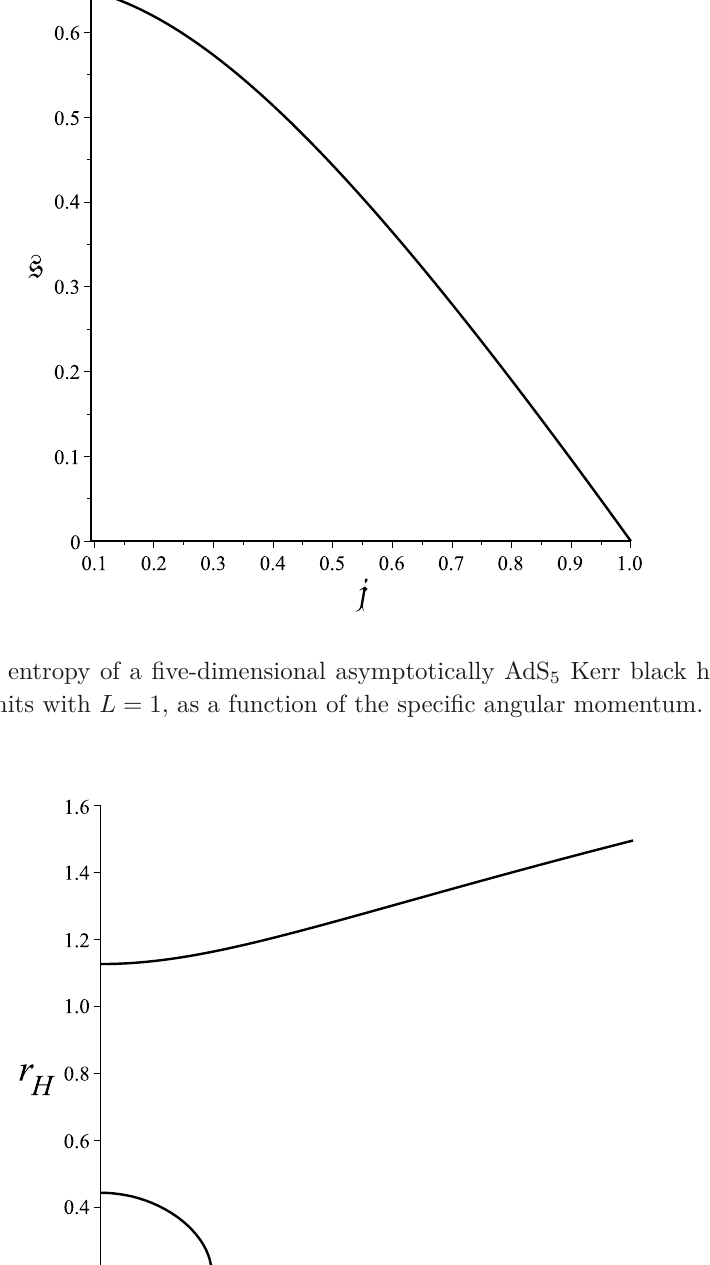
= 0 . 5. The domain is the physical one, 5 j < ≤